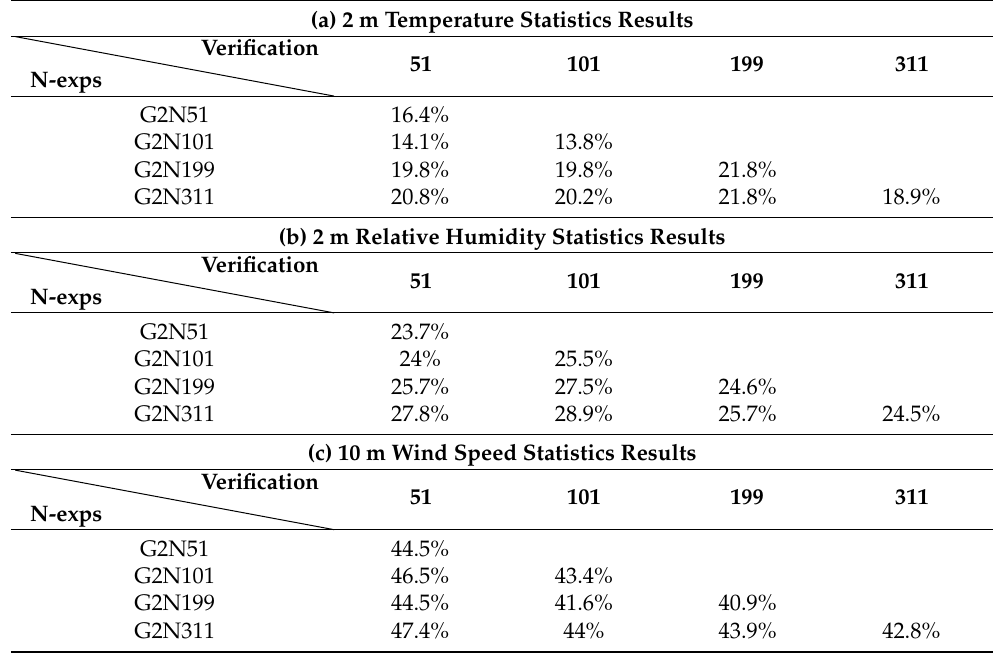
Table 3. Improvement percentages of RMSE for the N-Exps with the G2N model.